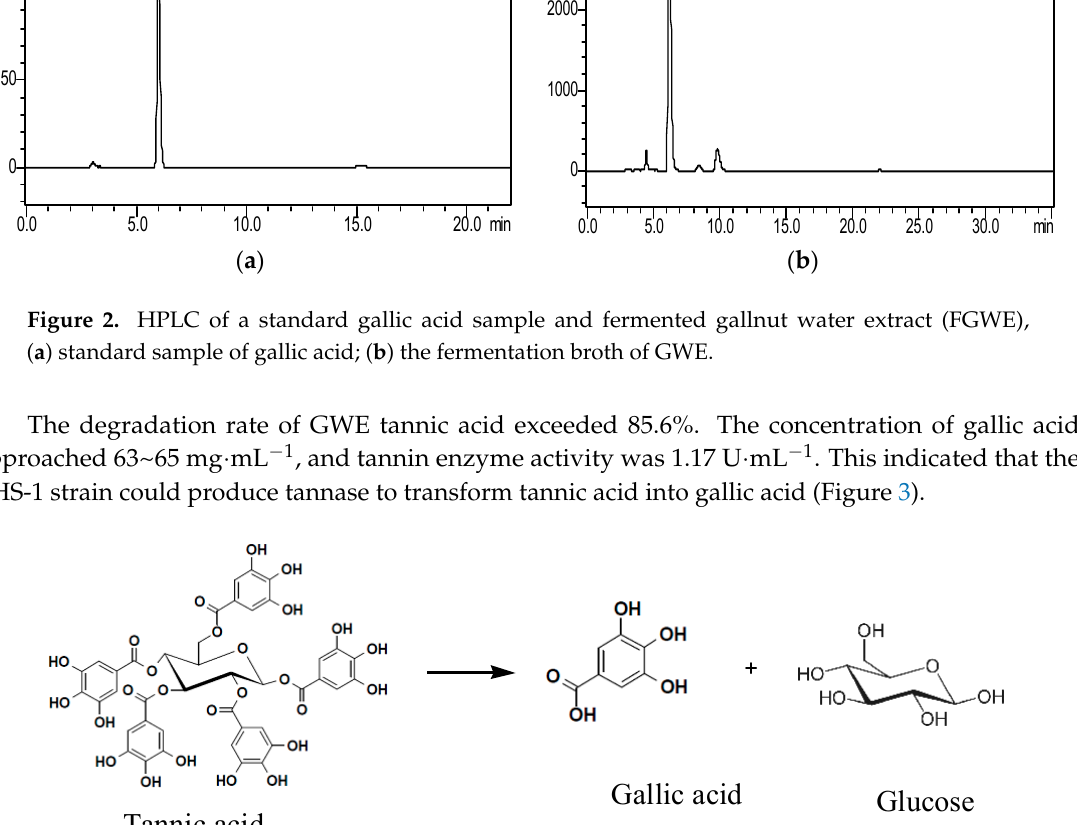
Figure 3. The degradation of GWE tannic acid into gallic acid.